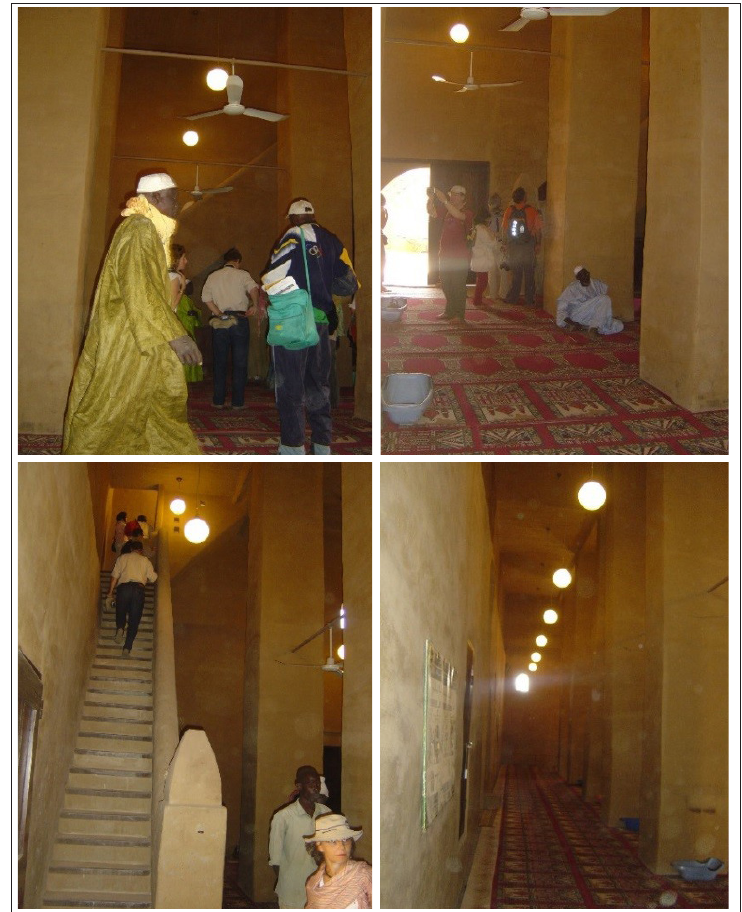
Figure 12: Interior spaces of the Great Mosque of Mopti, Mali, West Africa Source: Author,